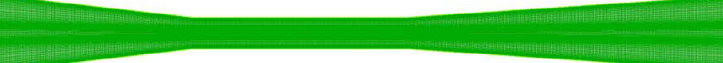
Figure 3. The structural grid of the computational domain.